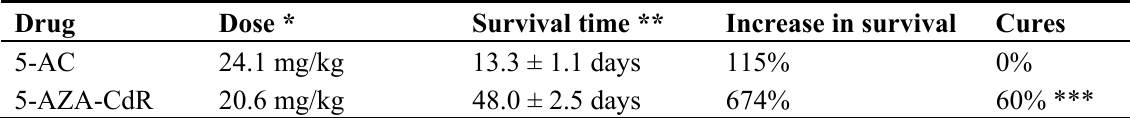
Table 1. Comparison of antineoplastic activity of 5AZA-CdR and 5AC in mouse model of L1210